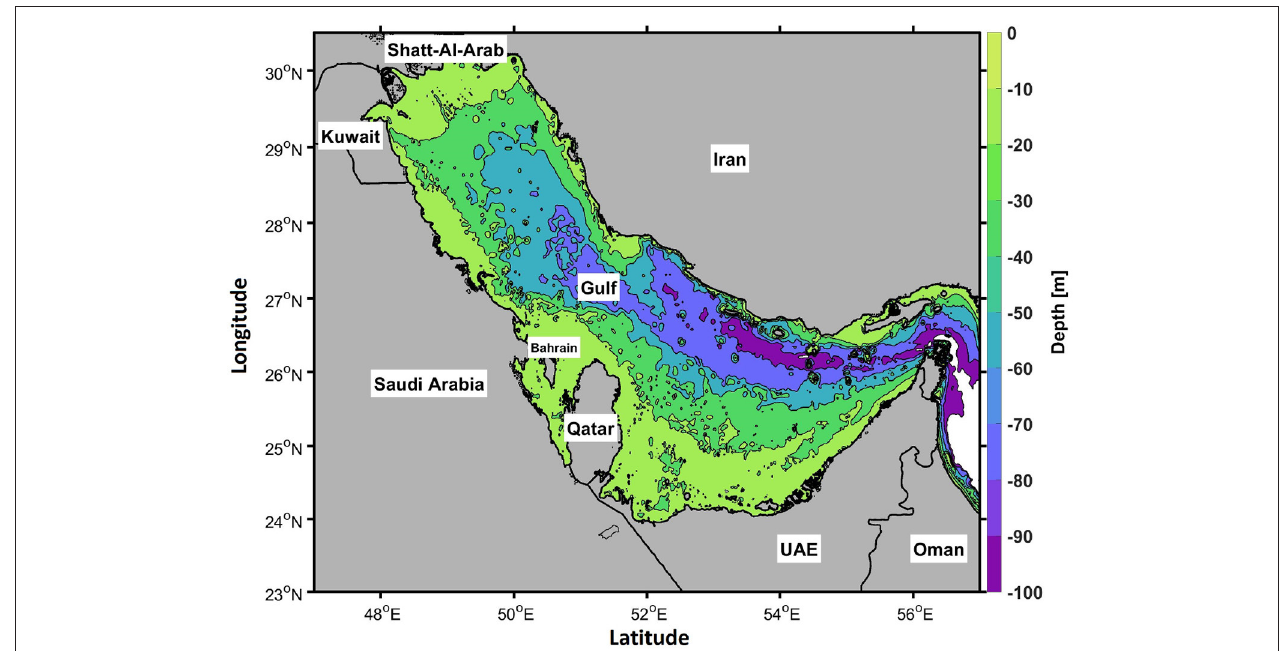
FIGURE 1 | Bathymetry map of the Gulf.